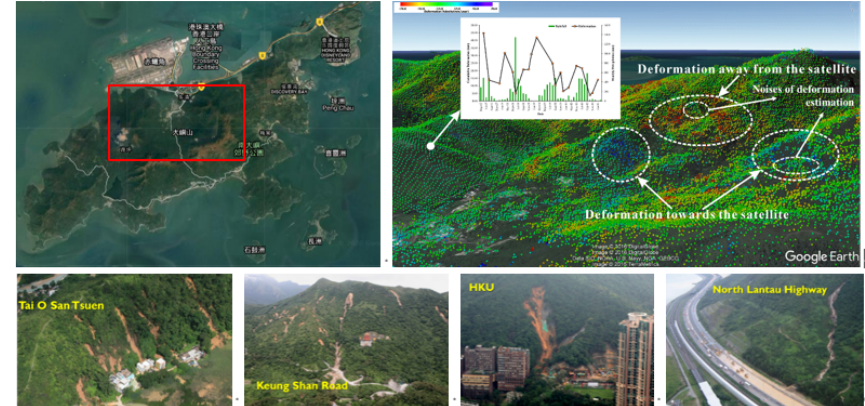
Figure 1 Top left: Optical image of Lantau Island, Hong Kong Top right: Mean velocity from ALOS-1/PALSAR-1, Lantau Island, direction of satellite line of sight Bottom: Landslide impact of June 2008 rainstorm in Hong